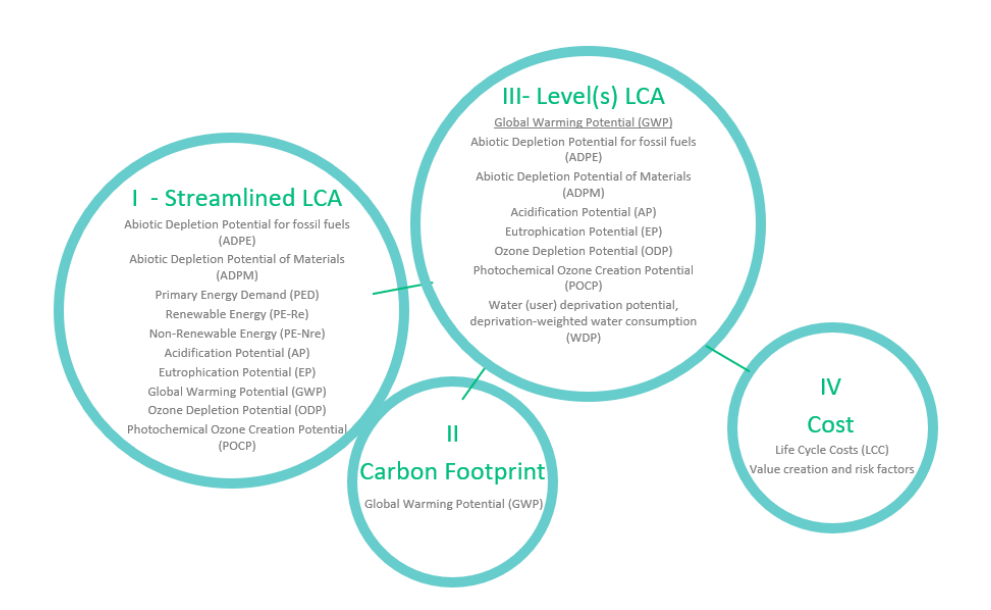
Figure 3. Plugin Functionalities with